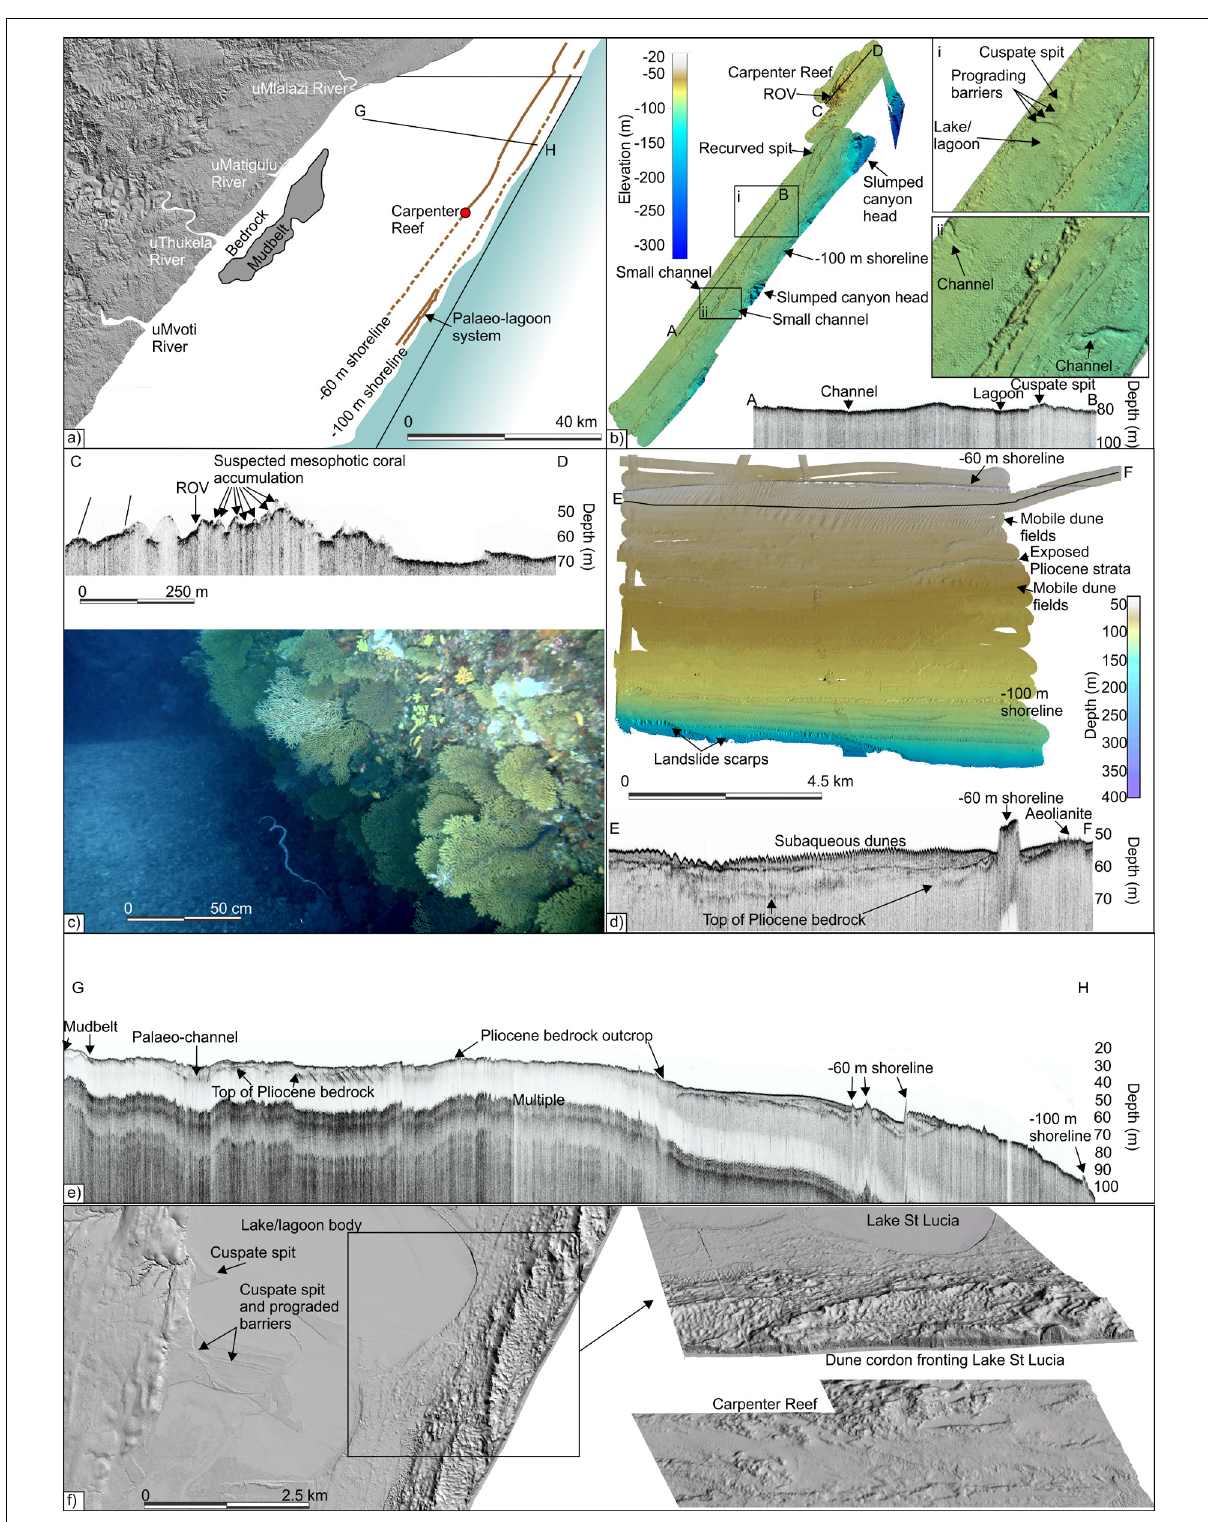
Figure 6: (a) Shoreline sequences preserved on the shelf of the uThukela Banks Marine Protected Area (MPA). (b) Multibeam bathymetry and seismic reflection profiles of a segmented lagoon complex preserved at -100 m. (c) Seismic reflection profile (top) over Carpenter Reef (location in a) showing raised and acoustically transparent material above the aeolianite surface, confirmed as mesophotic octocoral and black coral assemblages (bottom). (d) Multibeam (top) and seismic reflection profile (bottom) of a linear and narrow shoreline at 60 m water depth, fronted to seaward by unconsolidated sandy sediments shaped into subaqueous dunes. (e) Cross-shelf seismic reflection profile (location in a) detailing the Pliocene outcrop in the mid shelf of the MPA, with the -60 and -100 m shorelines. Note the inshore mud deposits and a deep palaeo-channel in the inner shelf. (f) Comparison between high-resolution terrain models of Lake St Lucia and Carpenter